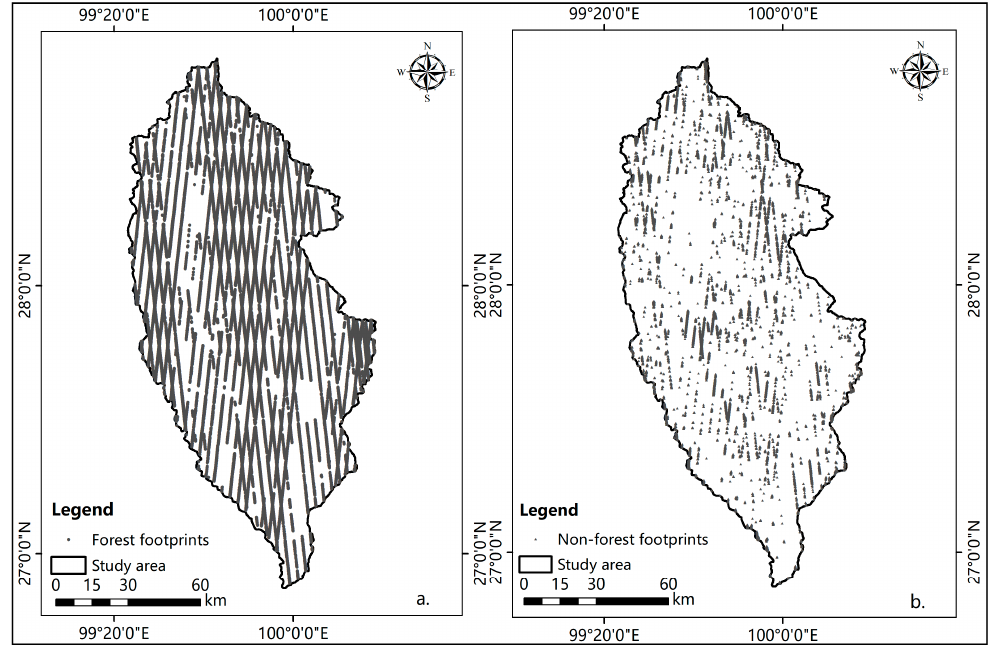
Figure 5. Schematic diagram of effective footprints in the study area. ( a ) Forest footprints. ( b ) Non- forest footprints.